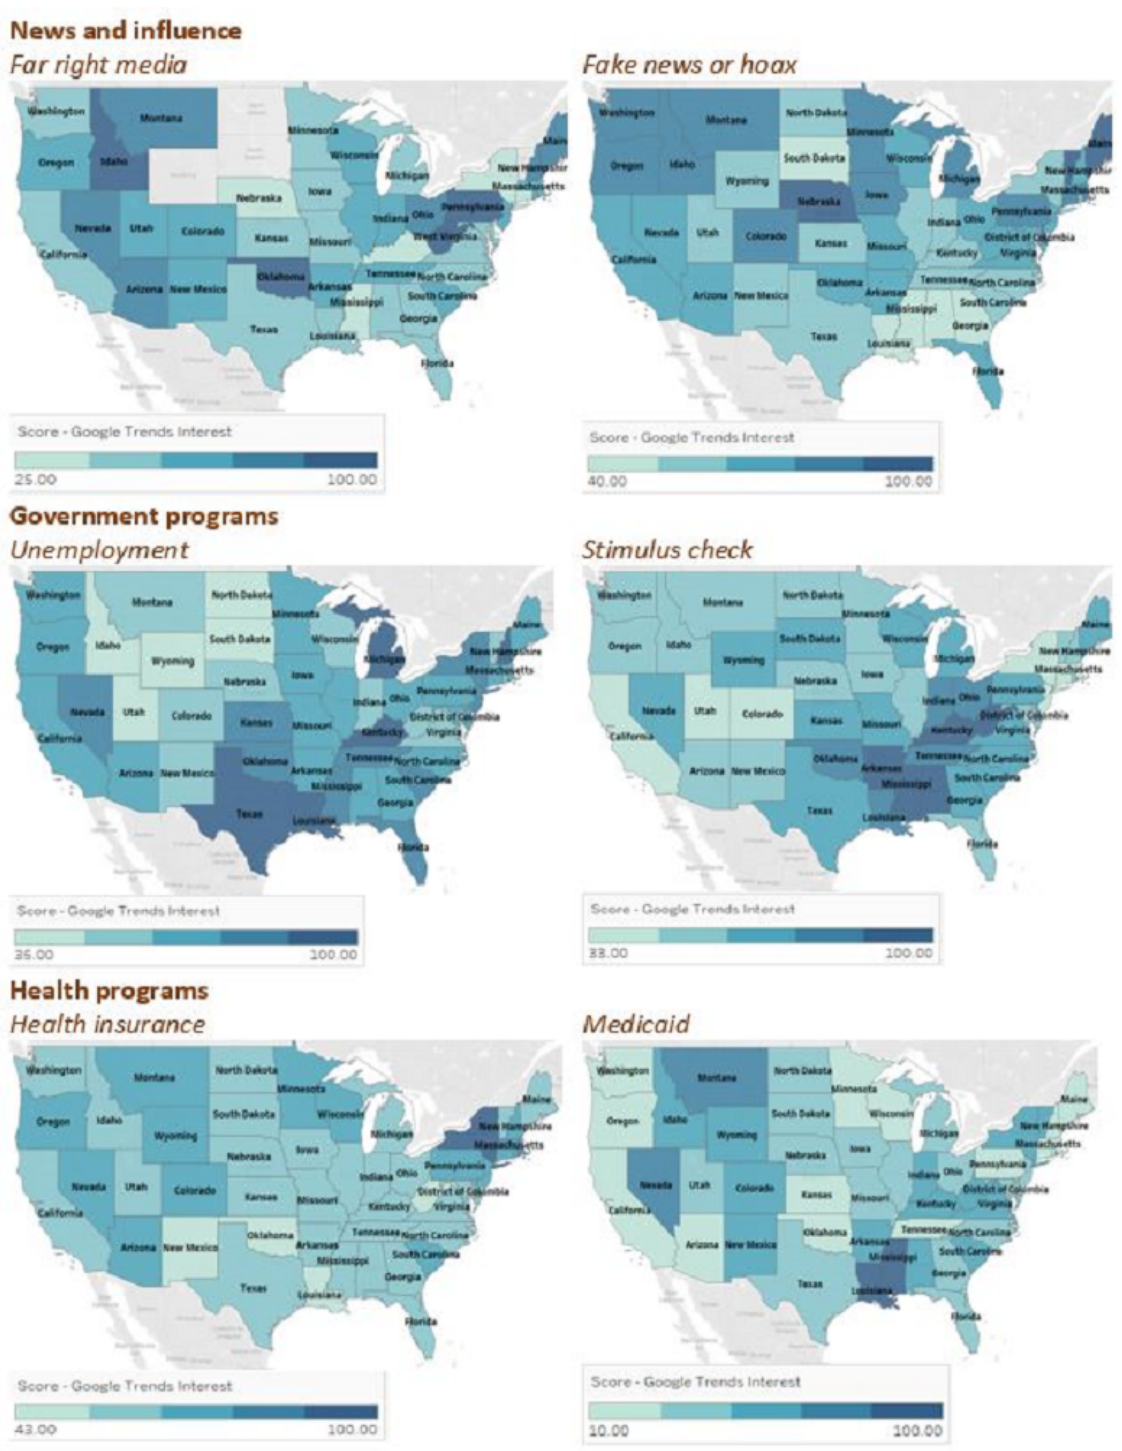
Figure 5. Geographical variations across states from March 1 to April 15, 2020, for the news and influence, government programs, and health programs themes. The figure shows the two queries that were most representative of each